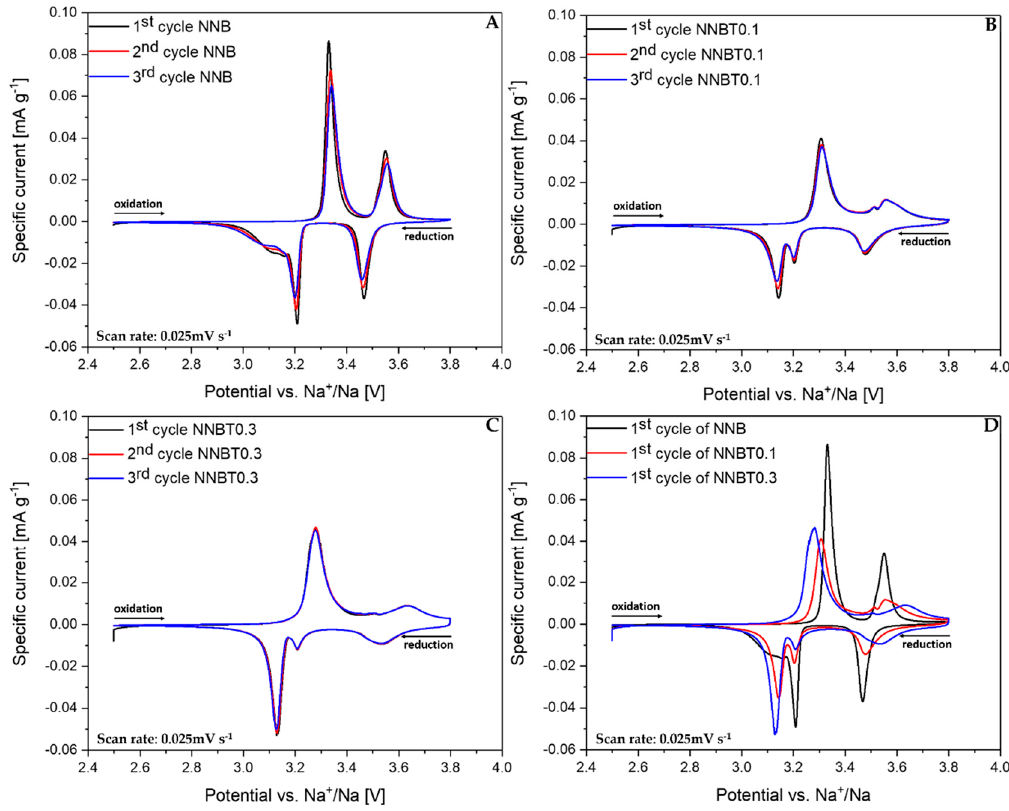
Figure 6. Normalized cyclic voltammograms (CV) of NNB, NNBT0.1 and NNBT0.3 at a scan rate